Question: Identify the chart type used in this figure.
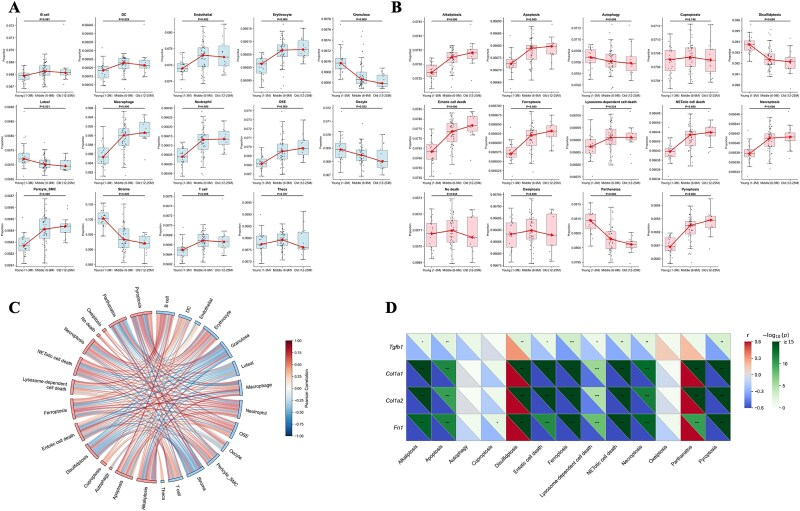
Answer: heatmap